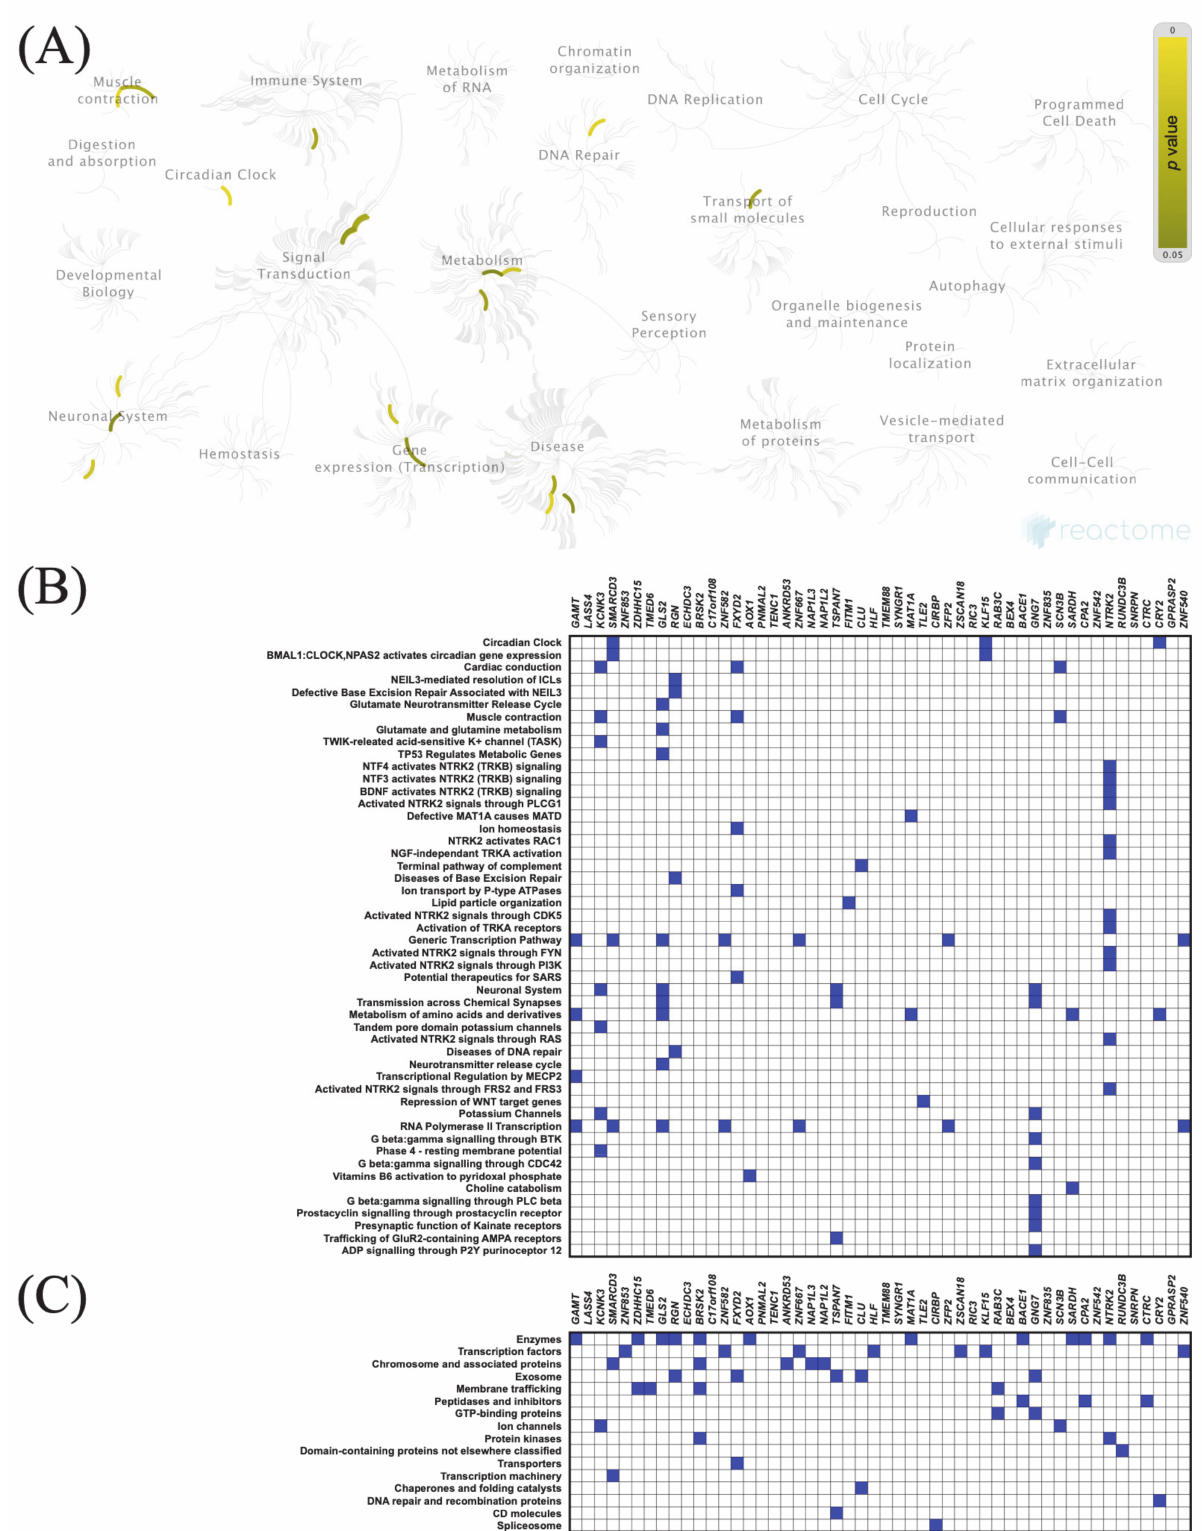
Figure 6. Functional enrichment analysis based on the TCGA dataset and UALCAN web tool. ( A , B ) The top 50 genes and Reactome pathways negatively correlated with KIF11 expression; ( C ) BRITE functional hierarchies for the top 50 genes that were co-downregulated with KIF11